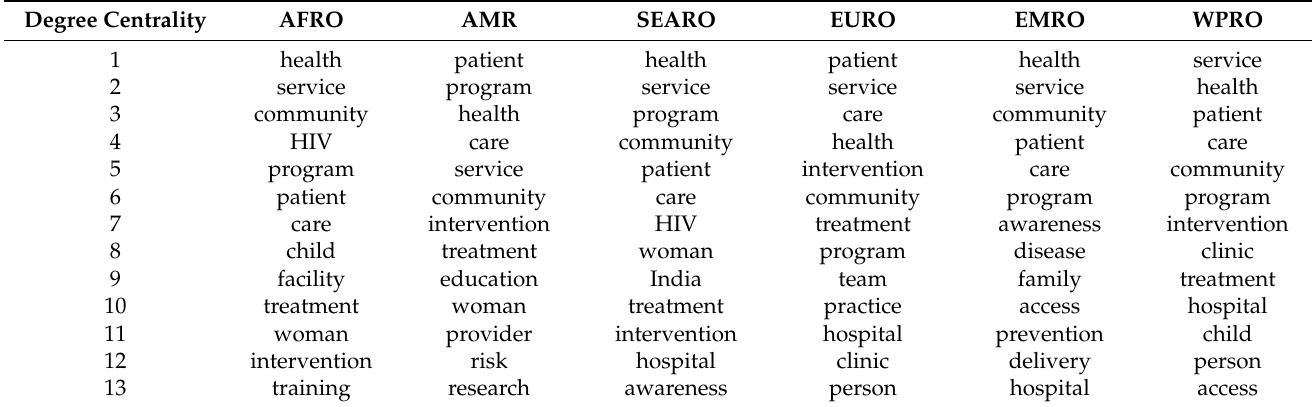
Table 3. Top 30 Keywords of Degree Centrality each